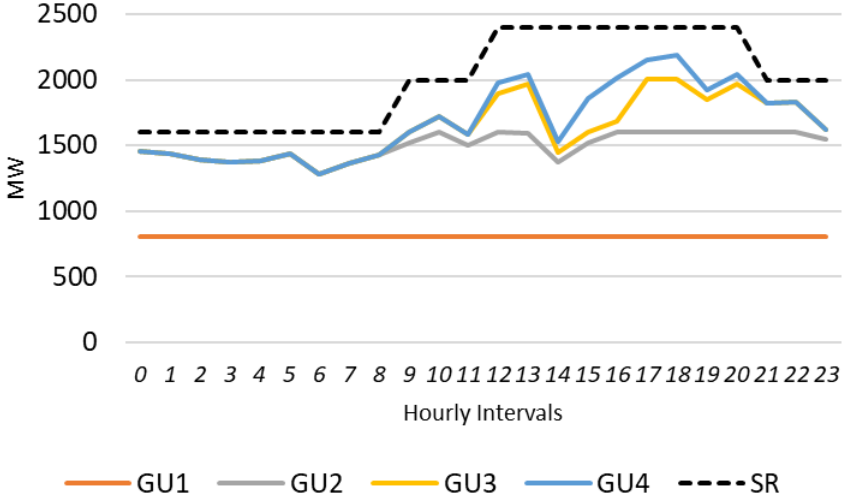
Figure 11. Optimal UC schedule obtained by the proposed approach in a real-world scenario.